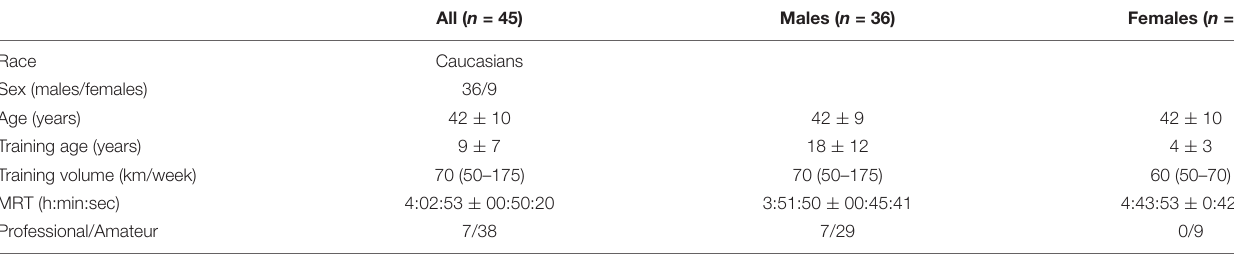
TABLE 1 | Demographic, training, and race performance characteristics of the athletes.